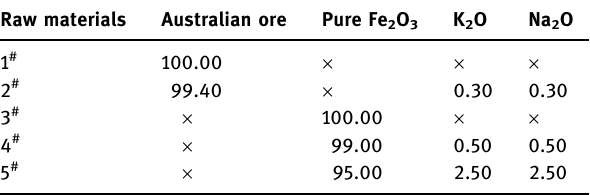
Composition T Fe Australian